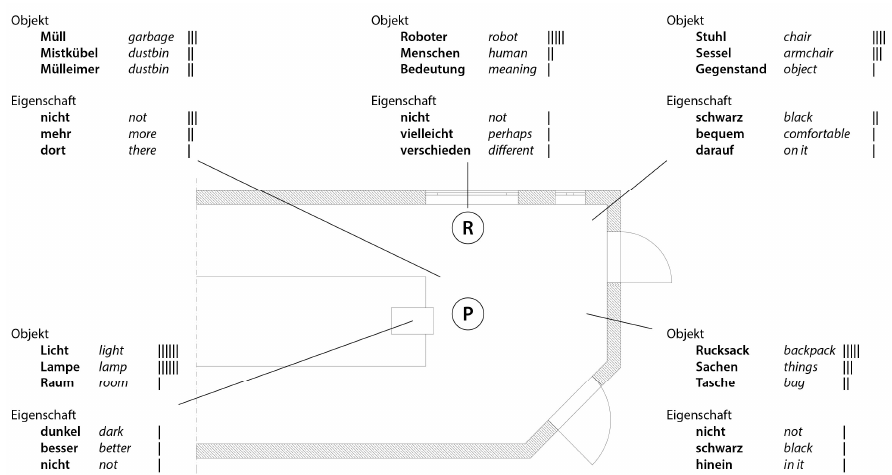
Figure 4. Floor plan of the experimental area with location of the five objects, translated into English, the robot (R) and the interview partner (P). Naming of object, function attributed to object, property associated to function and object. Bars indicate how often names and functions were mentioned.